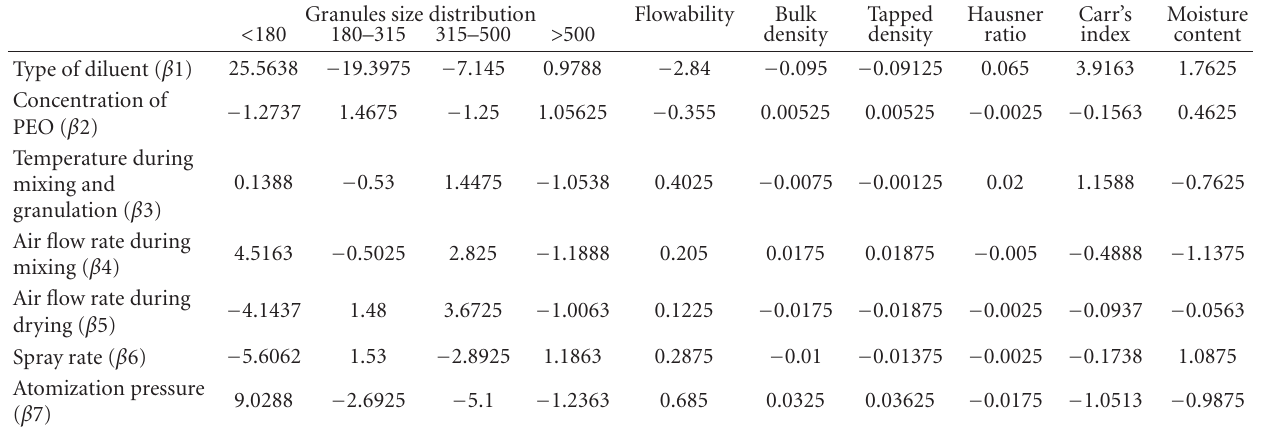
Table 6: Analysis of inf luence formulation and process factors on granules